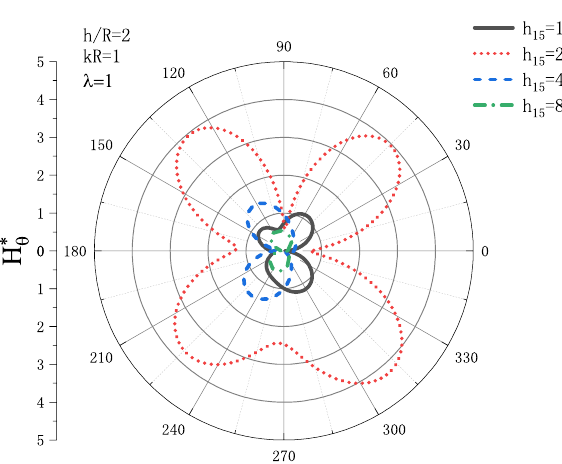
* h 15 when incident frequency kR = 1 θ vs. the ratio of